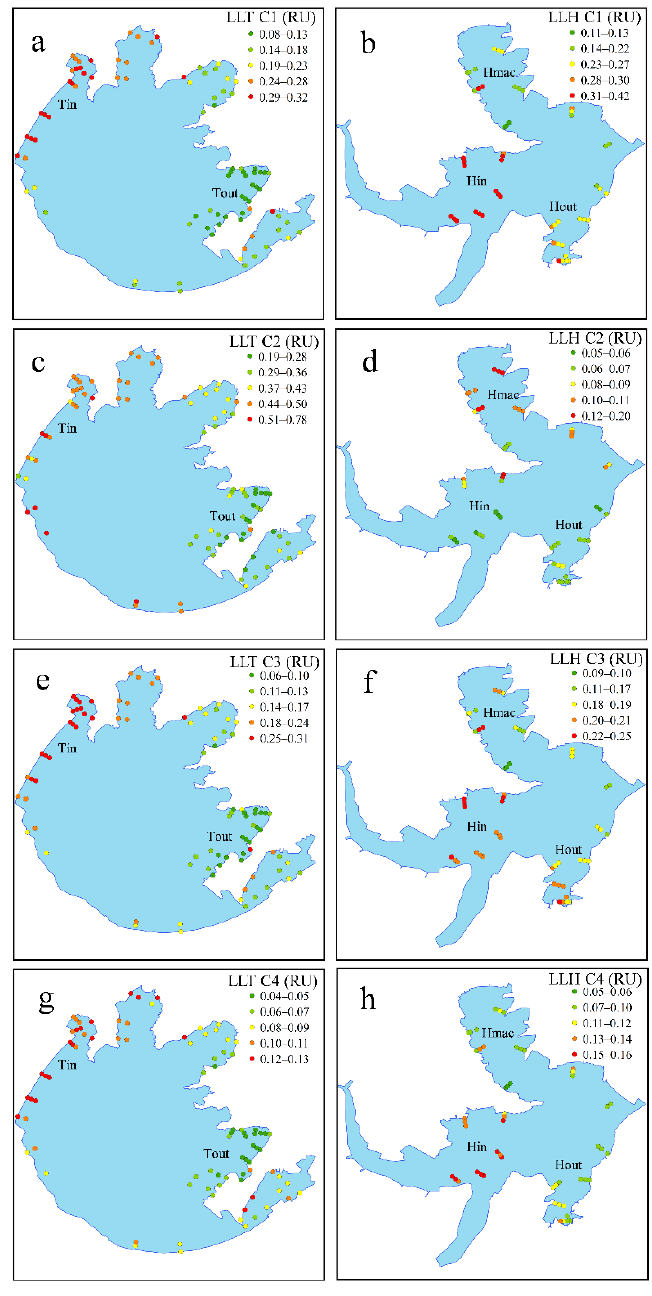
Figure 7. Distribution of each PARAFAC component inlittoral zones of Lakes Taihu and Hongze: ( a , c , e , g ) are C1, C2, C3, and C4 in LLT, respectively, and ( b , d , f , h ) are the corresponding C1, C2, C3, and C4 in LLH.